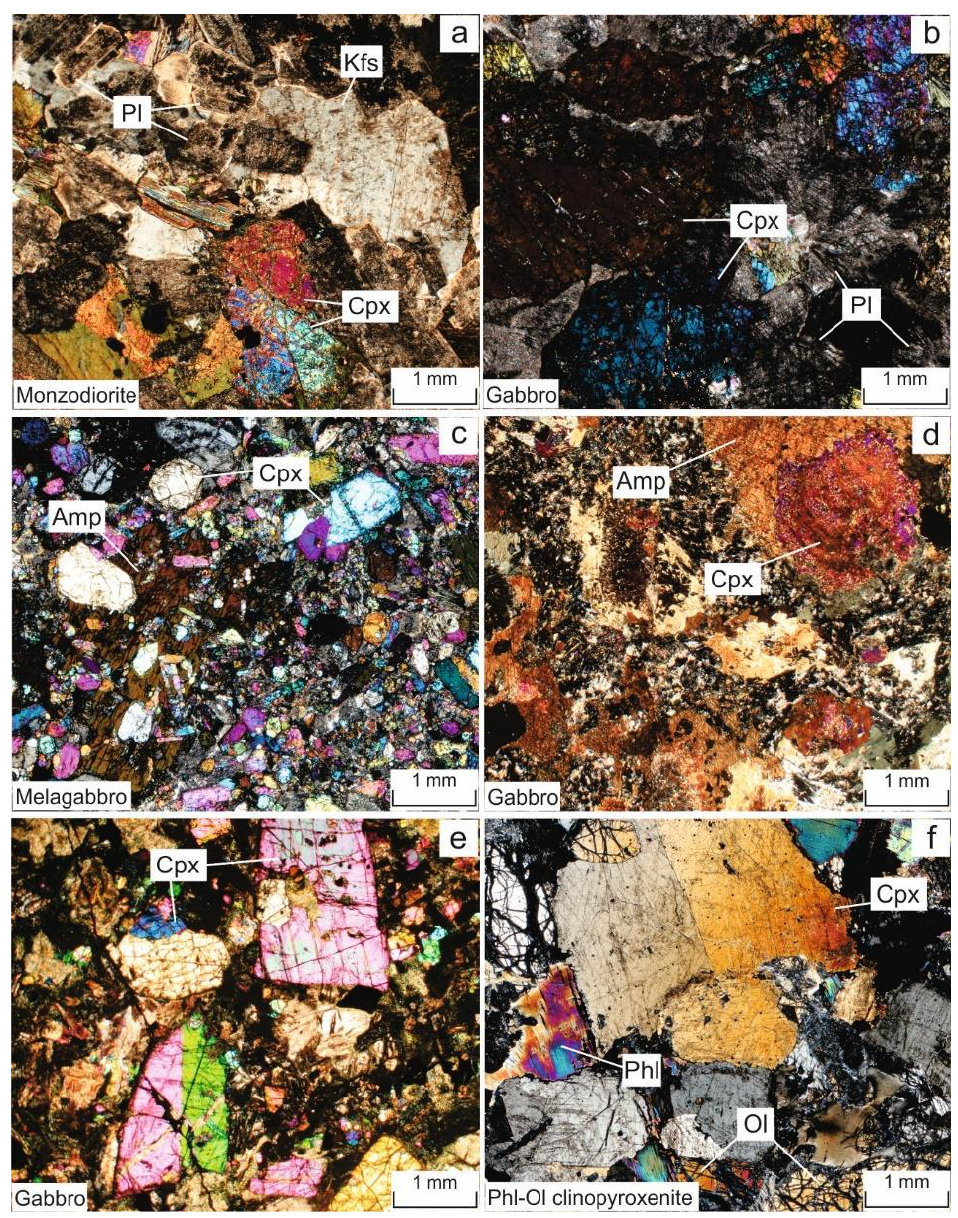
Figure 3. Microphotographs of thin sections of the rocks from different intrusions of the Barangol Complex, Gorny Altai (cross-polarized light): ( a – c ) Elanda intrusion; ( d ) Barangol intrusion; ( e ) Choburak intrusions; ( f ) Apshiyakhta intrusion. Amp—amphibole; Cpx—clinopyroxene; Kfs—K- feldspar; Ol—olivine; Phl—phlogopite;